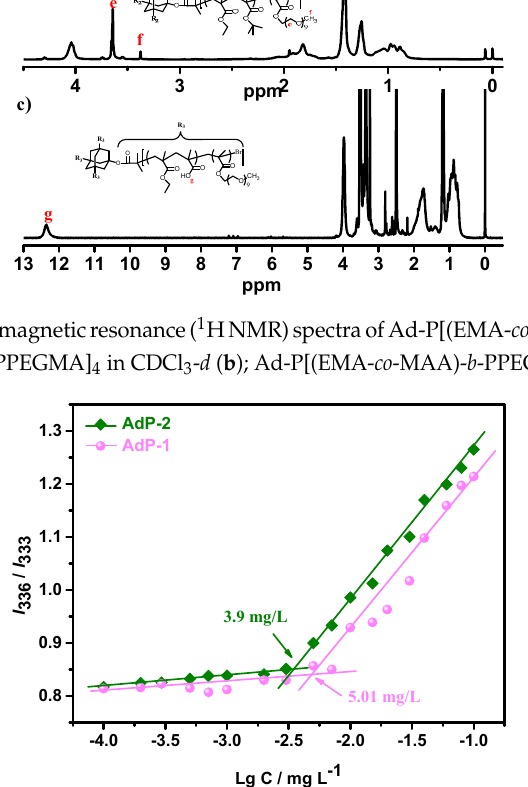
Figure 2. Critical micelle concentration (CMC) values of AdP-1 and